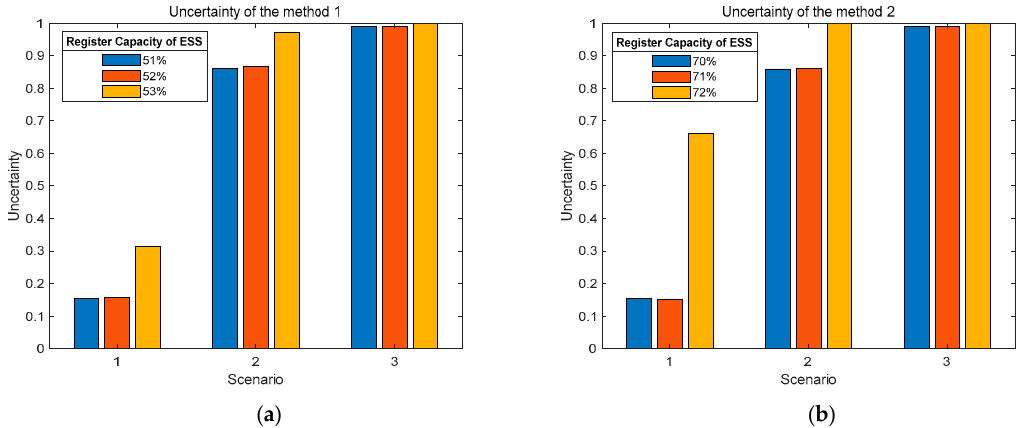
Figure 3. Uncertainty by ESS register capacity of each method: ( a ) method 1, ( b ) method 2.